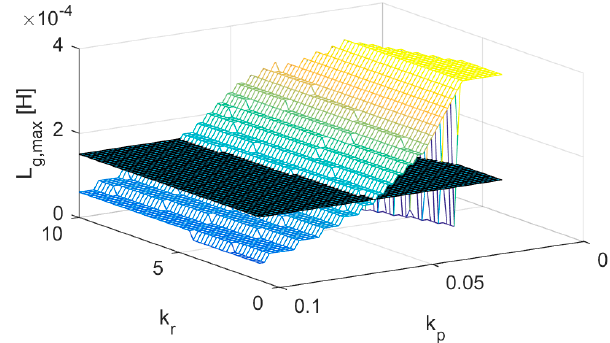
Figure 13. Maximal grid inductance value in function of k p and k r ,1 ; color indicates the value of L g,max .